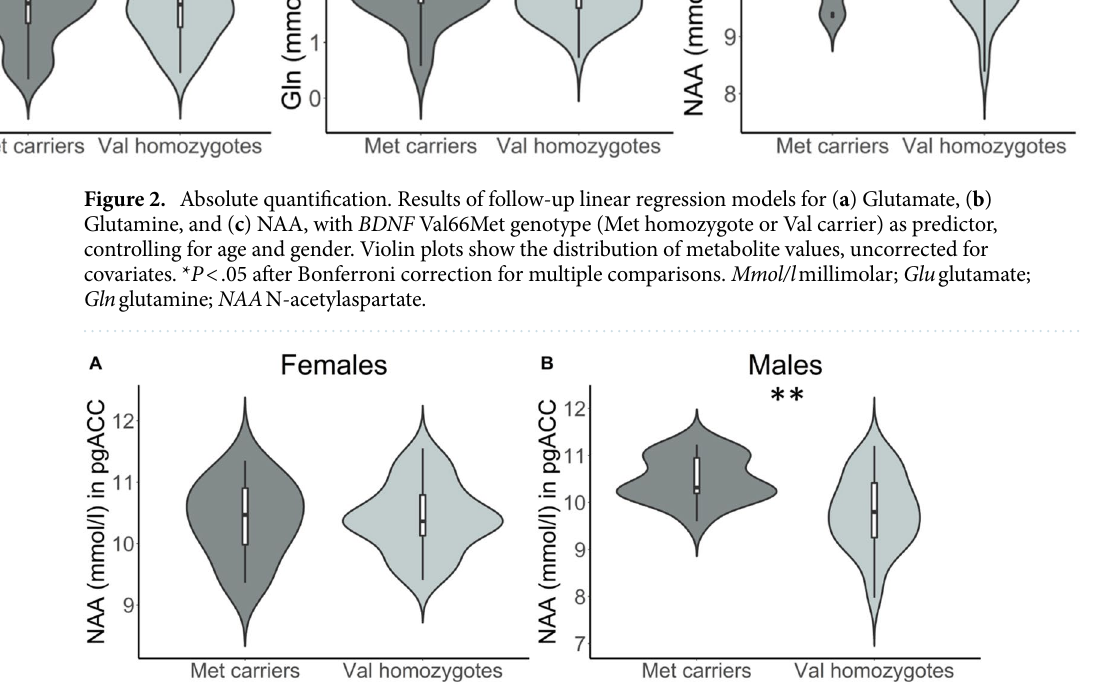
Figure 3. Gene-gender interaction on NAA. Results of follow-up linear models for female ( A ) and male ( B ) participants in cohort 2. Metabolite concentrations are corrected for the influence of age. mmol = millimolar. ** P <